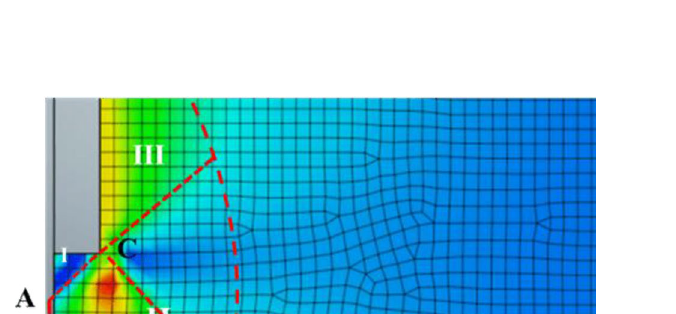
Figure 9. Change in the stresses around the pile and at the tip due to arching action 44 .